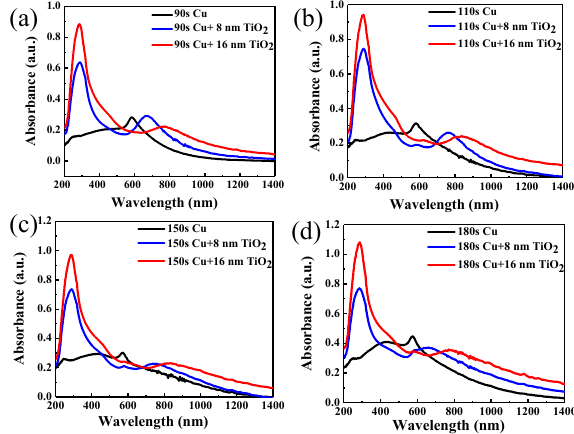
Figure 4. Absorbance evolution with TiO 2 thickness on copper nanoparticles with different deposition times: ( a ) 90 s, ( b ) 110 s, ( c ) 150 s, ( d ) 180 s.